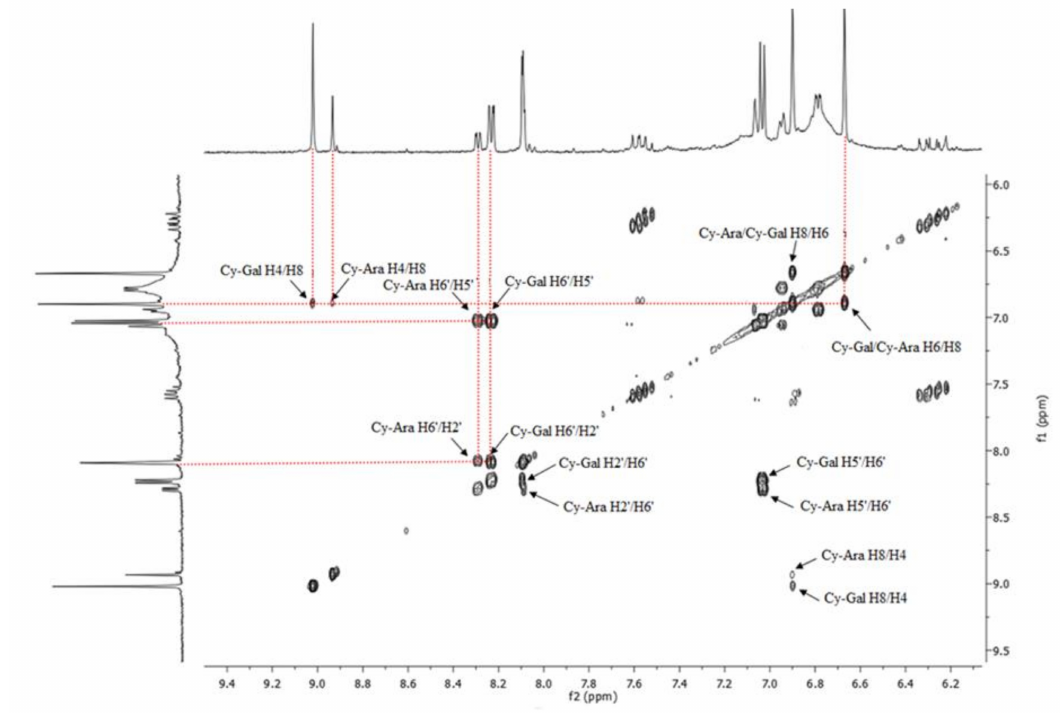
Figure 4. 1 H-NMR spectrum of sample LS6 (7th August) with diagnostic signals: H4, H6, H8, H2 (cid:48) , H5 (cid:48) , and H6’ for anthocyanins, cyanidin galactoside (Cy-Gal) and cyanidin arabinoside (Cy-Ara).